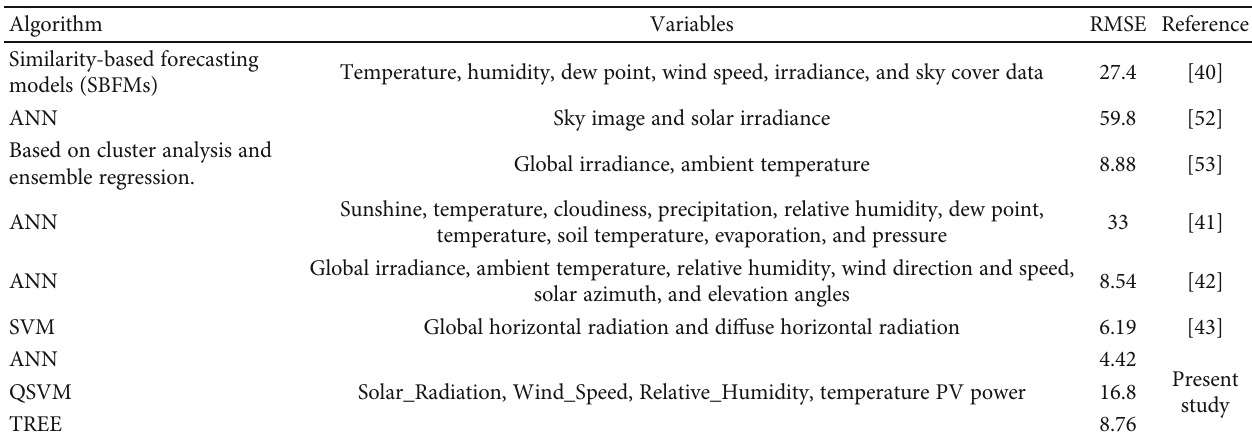
Table 3: Comparison of the RMSE of earlier